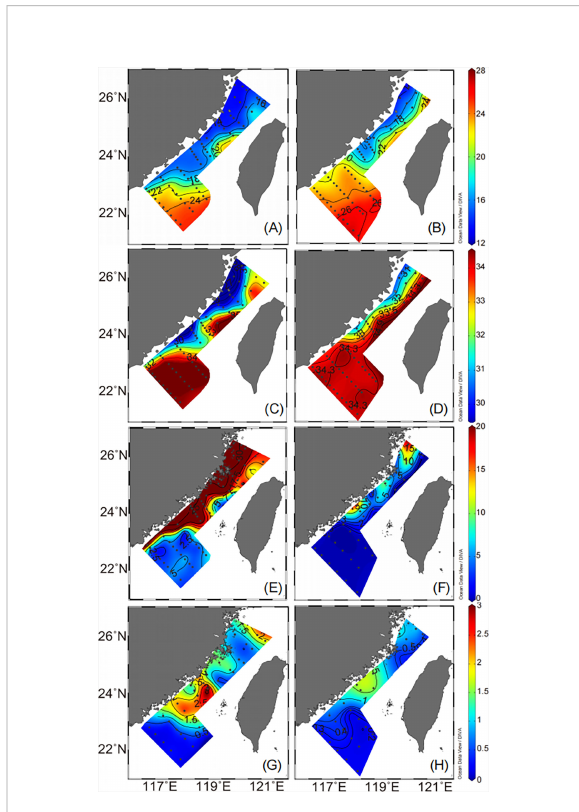
FIGURE 4 Surface temperature (°C, A, B ), salinity (C, D) , NOx ( m mol L − 1 , E, F ) and chlorophyll a ( m g L − 1 , G, H ) in the Taiwan Strait during the observations in 2016 (A, C, E, G) , and 2018 (B, D, F, H)